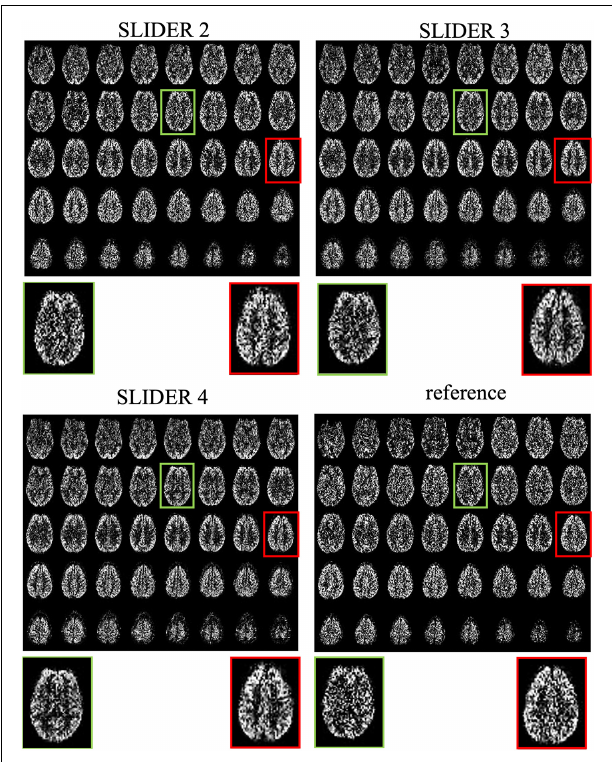
FIGURE 3 | SLIDER super-resolution reconstructed ASL images and acquired reference ASL images in the axial direction. The reconstructed images follow the reference images well, with an improved SNR. The red and green boxes and zoomed images show two slices with SNR